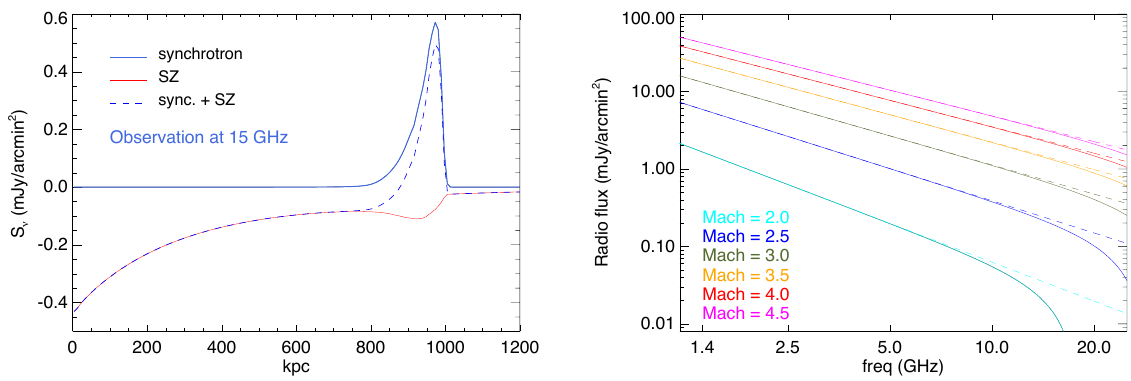
Figure 1. Sunyaev–Zel’dovich (SZ) effect contamination at GHz-frequency observations of radio relics (from [17]). Left: Projected synchrotron and SZ effect signals at the location of a radio relic based on a simple spherical shock model, illustrating the decrease in the observed synchrotron flux. Right: Model spectra for radio relics in the GHz frequency range, based on a linear Mach dependence of the synchrotron-to-SZ flux ratio. The dashed lines are the uncontaminated spectra, which follow a power-law at all frequencies. (Credit: Basu, K., et al. A&A, 591, A142., 2016, reproduced with permission ©ESO.)